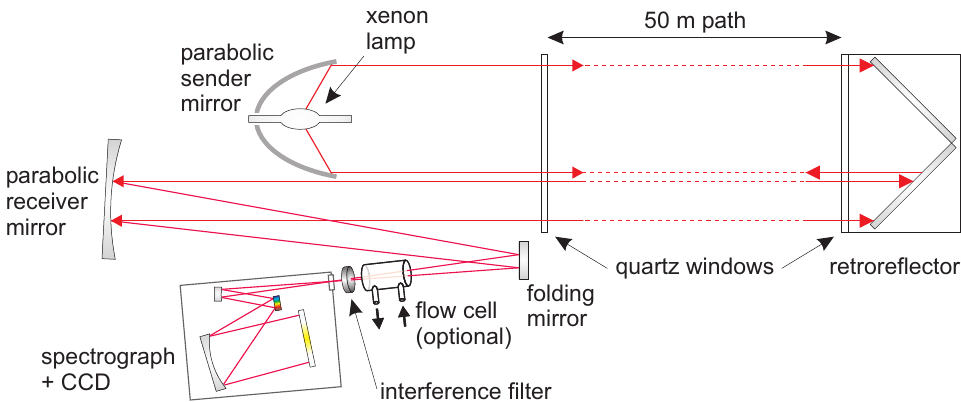
Fig. 6. Schematic overview of the miniDOAS design. The light of a xenon lamp is directed by the parabolic mirror to a corner cube retroreflector, placed at a distance of 50 m. The light is reflected back to the receiving mirror by the retroreflector. With the use of a folding mirror the light is focussed onto an spectrograph with an integrated CCD detector, after passing through an interference filter. The flow cell is optional and is used to supply known amounts of trace gases for calibration measurements.